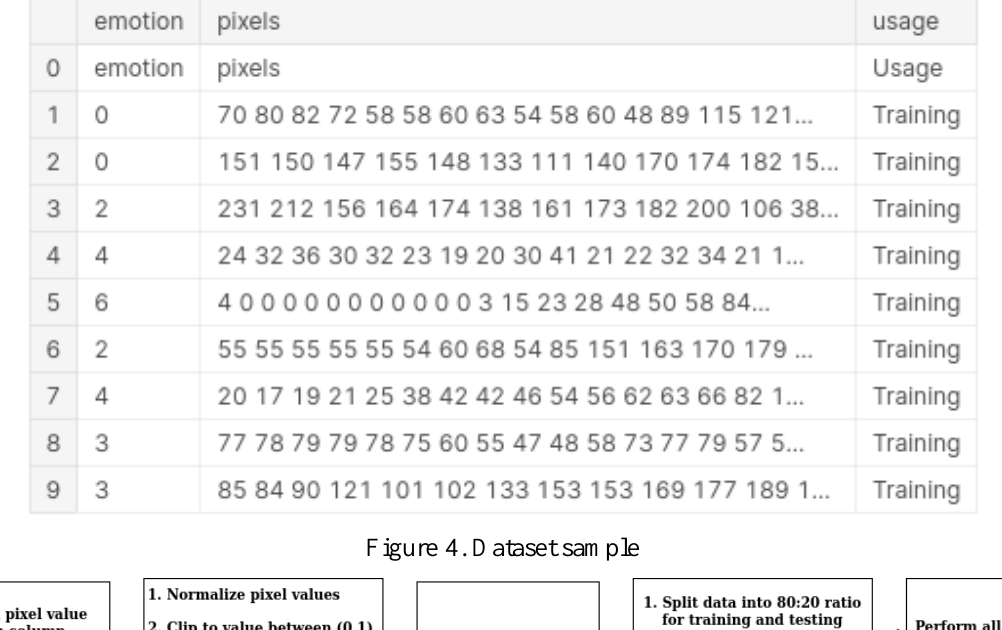
Figure 5. Image normalization, Gaussian noise addition, and clipping